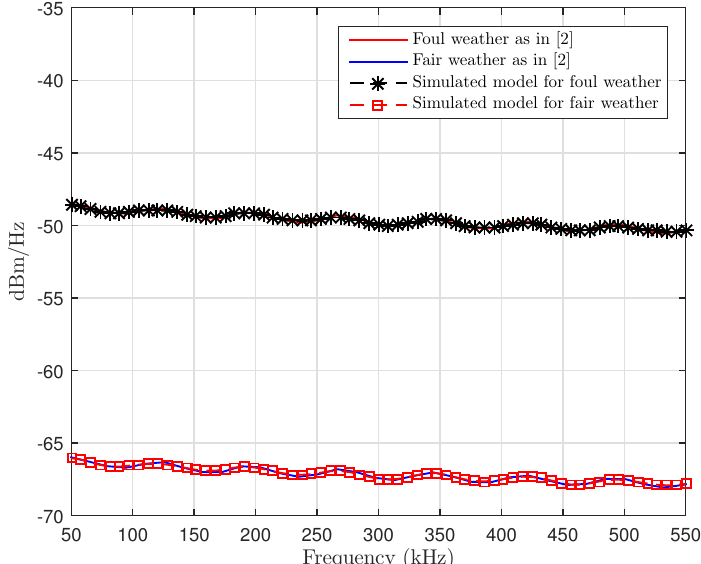
Figure 7. Power spectral density of the corona noise for the test-case line with 400 kV in the frequency range of operation [ 50,550 ]